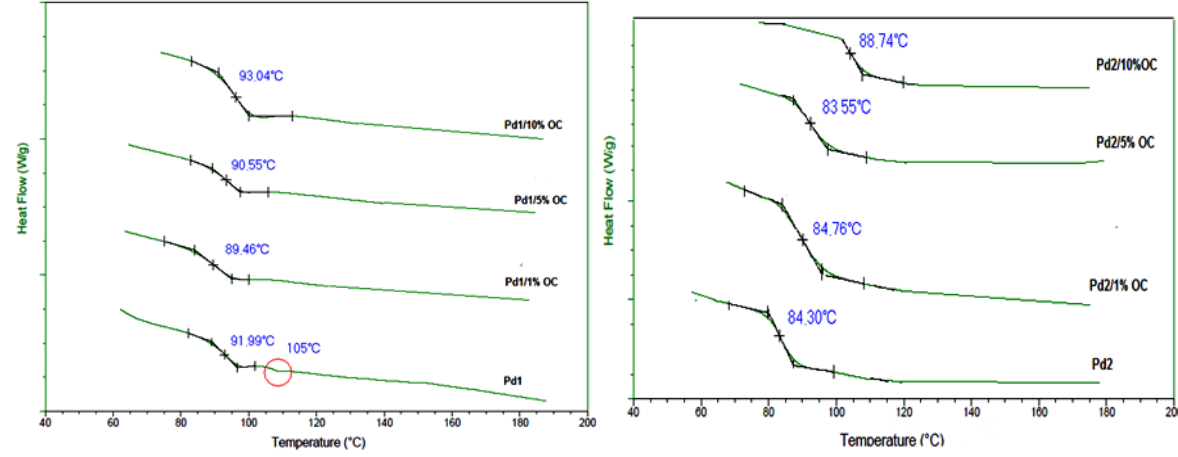
Figure 5: Differential Scanning Calorimetry(DSC) thermogram of Pd1(PS/PVA:10/90),Pd1/1%OC, Pd1/5%OC, Pd1/10%OC, Pd2(PS/ PVA:90/10), Pd2/1%OC, Pd2/5%OC, Pd2/10%OC.